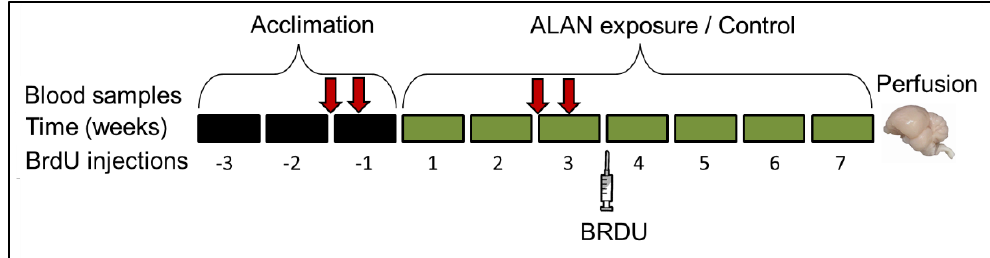
Figure 5. A schematic illustration of the experimental design. Top arrows indicate blood sampling; bottom syringe indicate BrdU treatment. See text for details.